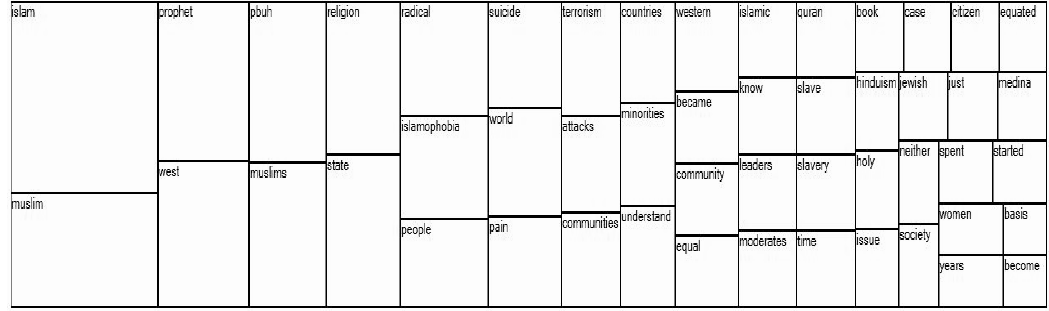
Religions 2022 , 13 , x FOR PEER REVIEW Figure 4. Tree-map of frequently used terms in the speech. Figure 4. Tree-map of frequently used terms in the speech.